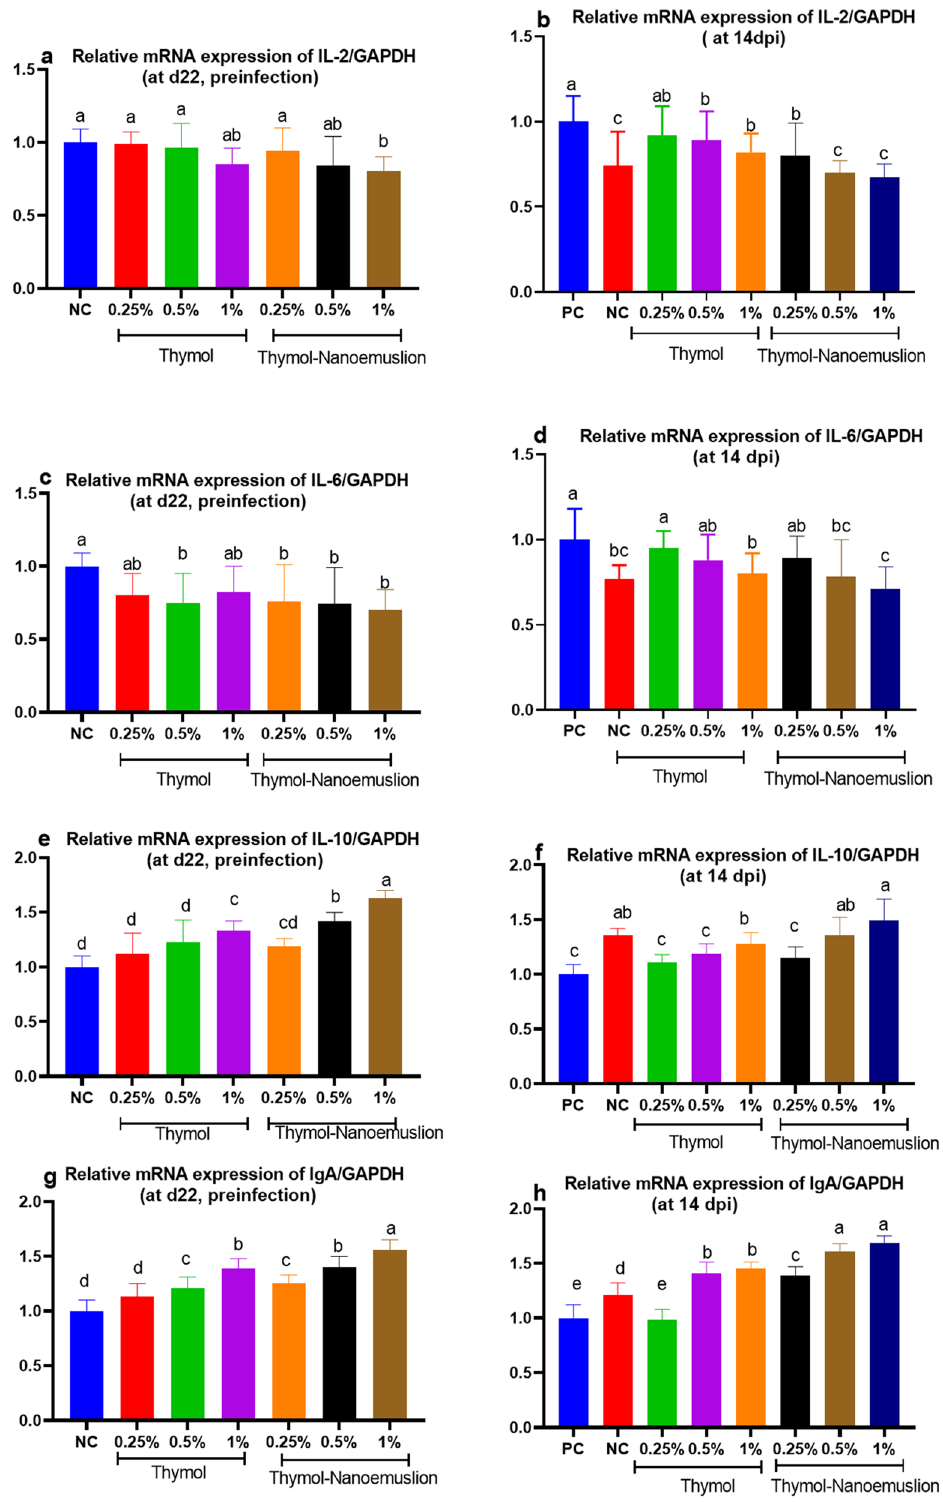
Figure 4. Relative mRNA expression levels of interleukin-2 ( IL-2 ; a , b ) interleukin-6 ( IL-6 ; c , d ) interleukin-10 ( IL-10 ; e , f ) and immunoglobulin A ( IgA ; g , h ) in the spleen of broilers fed different levels of thymol and thymol nanoemulsion preinfection (d 22) and 14 days postinfection (14 dpi) with S. Typhimurium. Error bars represent SEM. At d 22 preinfection: NC (negative control) = birds fed basal diet, thymol 0.25, 0.5 and 1% = birds fed basal diet supplemented with 0.25, 0.5 and 1% thymol, thymol nanoemulsion 0.25, 0.5 and 1% = birds fed basal diet supplemented with 0.25, 0.5 and 1% thymol nanoemulsion. At 14 dpi: NC (negative control): birds fed basal diet; PC (positive control): birds fed basal diet and challenged with S . Typhimurium at d 23 of age; thymol 0.25, 0.5 and 1%: birds fed basal diet supplemented with 0.25, 0.5 and 1% thymol; thymol nanoemulsion 0.25, 0.5 and 1%: birds fed basal diet supplemented with 0.25, 0.5 and 1% thymol nanoemulsion. All groups except NC group were challenged with S . Typhimurium at d 23 of age. a–e Means within the same column carrying different superscripts are significantly different at p <